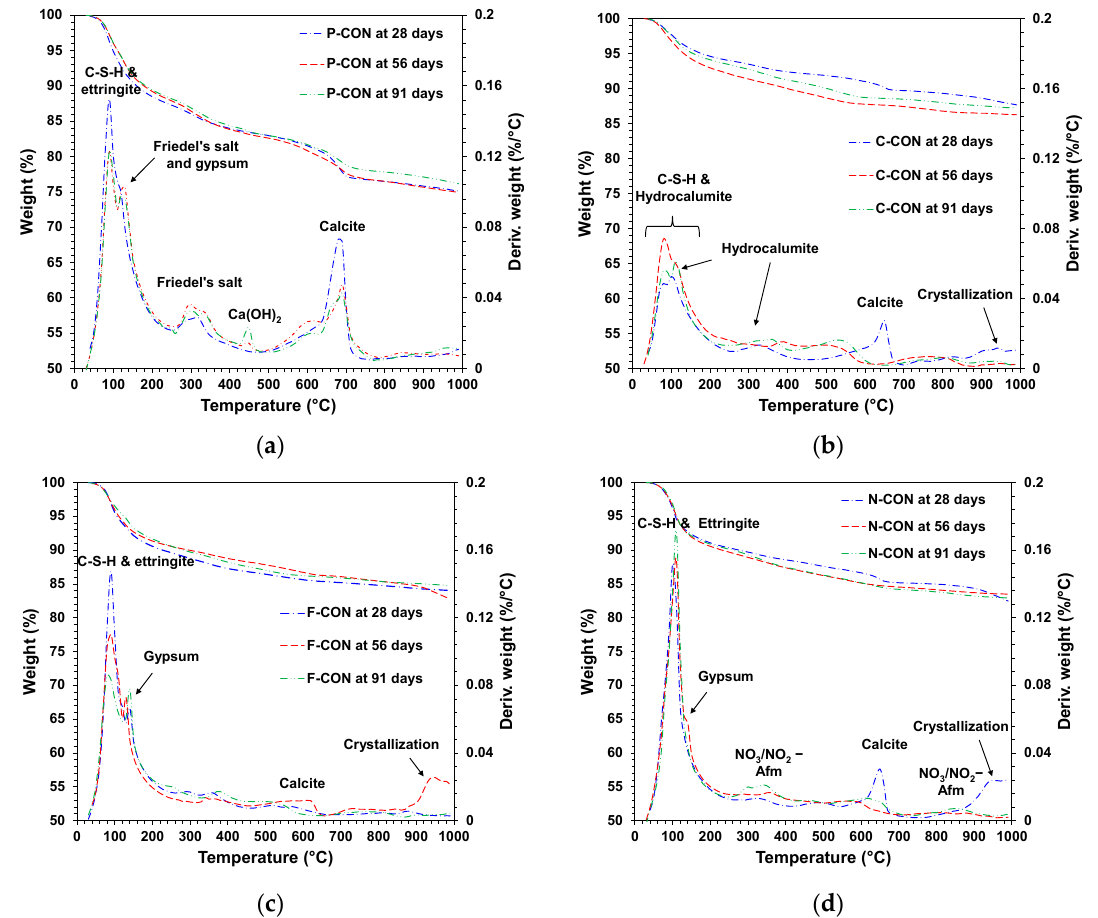
Figure 9. TG/DTG curves of hardened samples immersed in 5% HCl solution: ( a ) P-CON, ( b ) C-CON, ( c ) F-CON, and ( d ) N-CON.